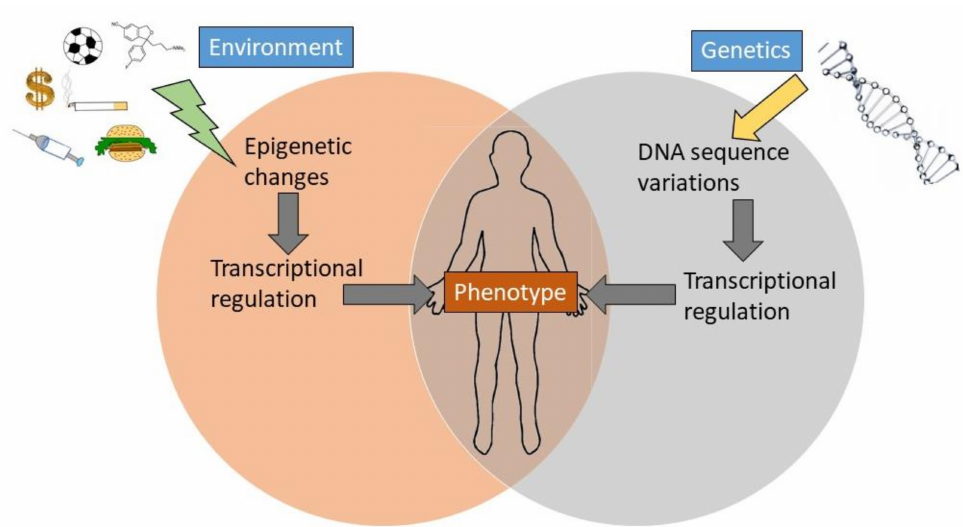
Figure 2. Environmental and genetic influences on the expression of phenotype. Development of polygenic conditions, such as diseases, depend on complex and interacting genetic and environmental pathways. Adapted from